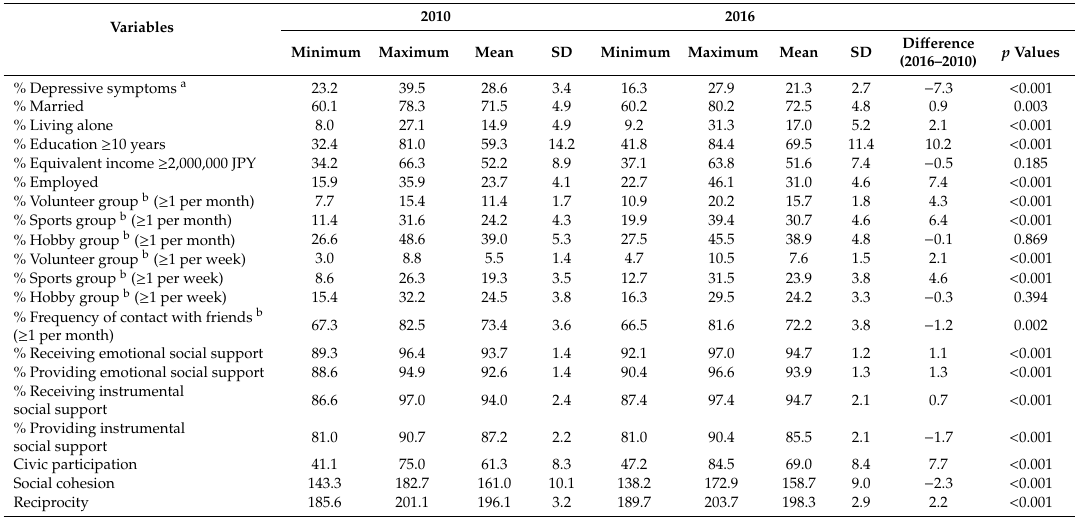
Table 1. Age-adjusted descriptive statistics of community factors (municipal units = 44).